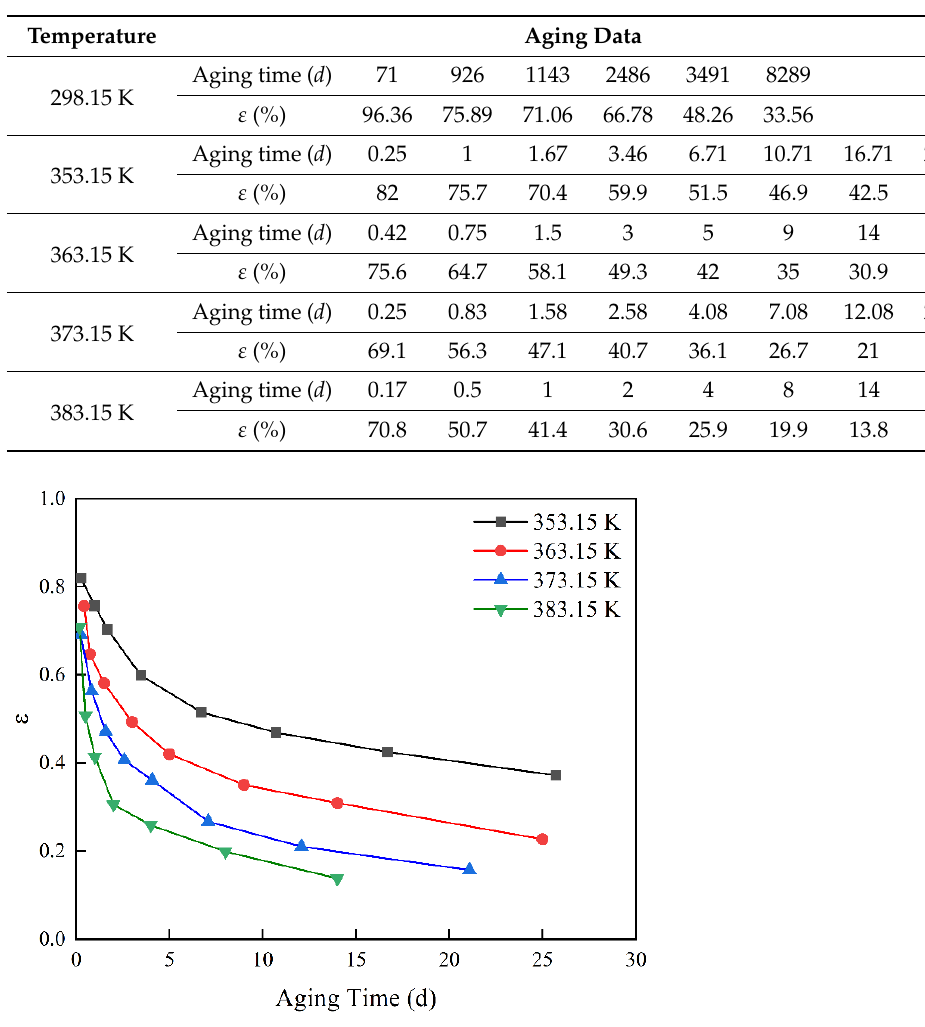
Table 1. Compression set retention ( ε ) at different aging temperatures [23].